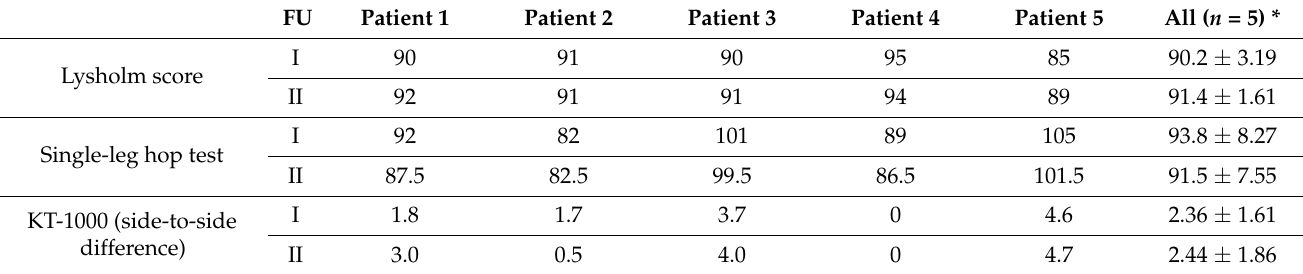
Table 2. Clinical and functional